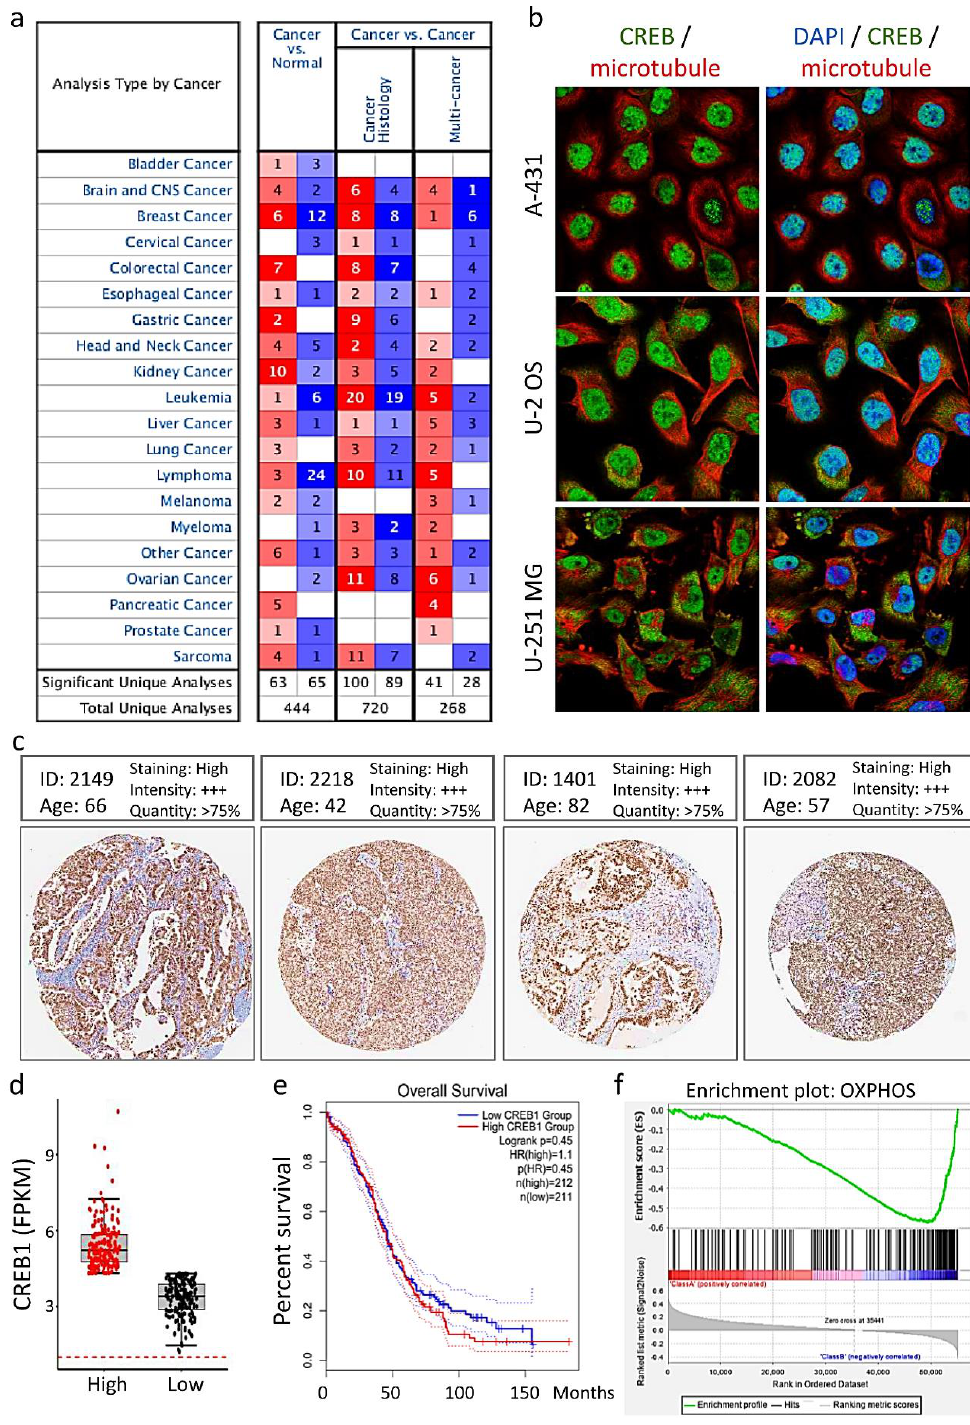
Figure 3. Diagnostic and prognostic value of CREB1 in OV. ( a ) The graphic was generated from the ONCOMINE database, indicating the number of datasets with statistically significant ( p < 0.01) mRNA overexpression (red) or downregulation (blue) of CREB1. ( b ) The localization of CREB1 protein in human cells. Blue: nucleus; Green: CREB1; Red: microtubules. ( c ) Comparison of immunohistochemistry images of CREB1 in OV tissues with four different patients based on the Human Protein Atlas (+++: strong staining). ( d ) Plots chart showing higher CREB1 expression in OV patients. Data were obtained from TCGA. ( e ) Kaplan–Meier curves was performed to determine differences in OV patients. ( f ) The association between CREB1 gene mutations and OV gene signature. Gene set enrichment analysis (GSEA) was performed to enrich the OV gene signature in the following data